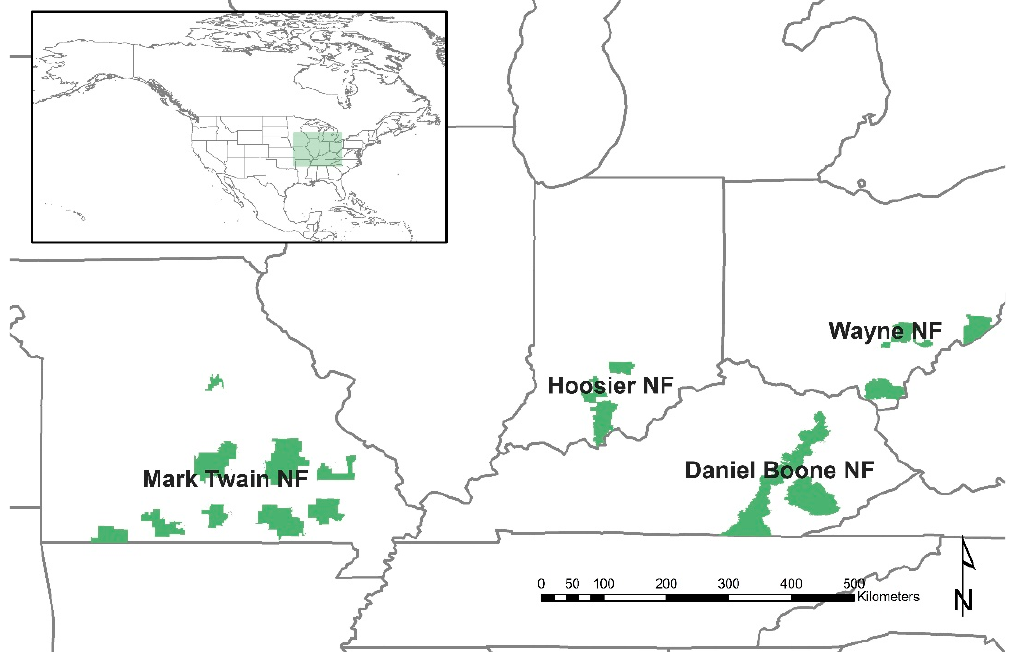
Figure 1. Locations for the four National Forests sampled in this study. Briefly, forests of the CHR are dominated by oak–hickory ( Quercus-Carya ) forest types. unglaciated, hilly areas with limestone and/or sandstone parent material. As a result,